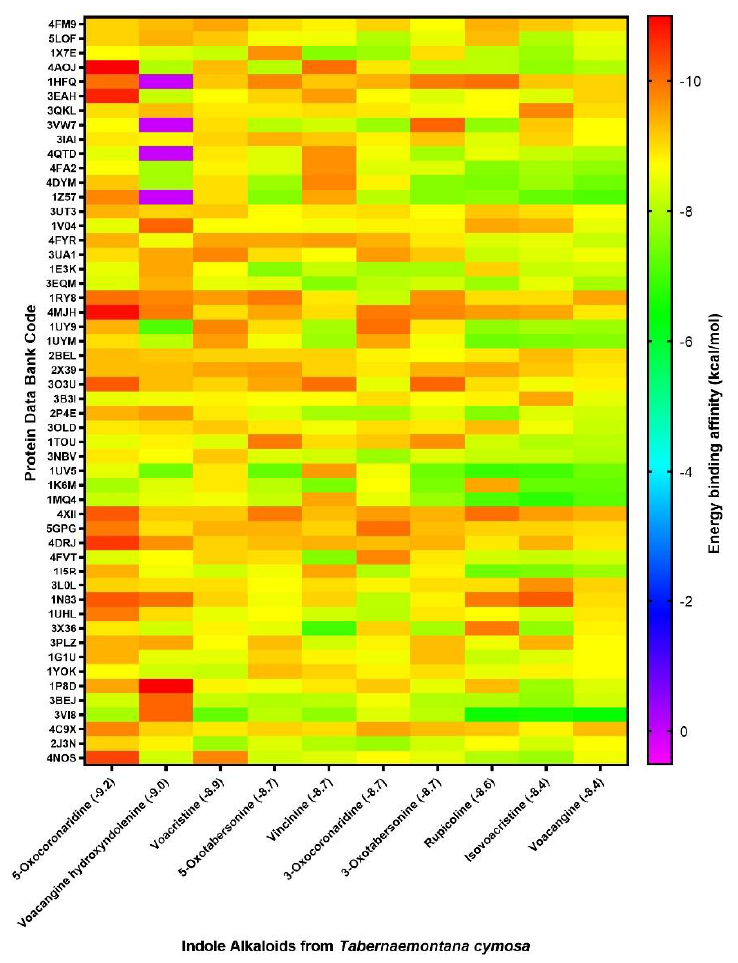
Figure 2. Heat-map of the molecular docking affinities values (kcal/mol) for indole alkaloids with human proteins. Values in parenthesis indicate the average binding energy for each molecule. Table 2. Potential targets and binding affinities of Tabernaemontana cymosa alkaloids to human proteins.